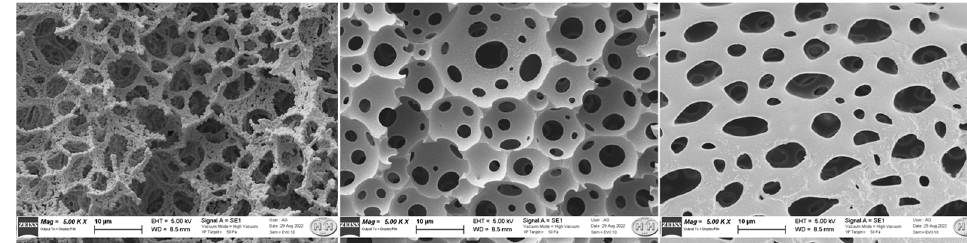
Figure 3. SEM images at different magnifications of the MIP-polyHIPE (after template removal).